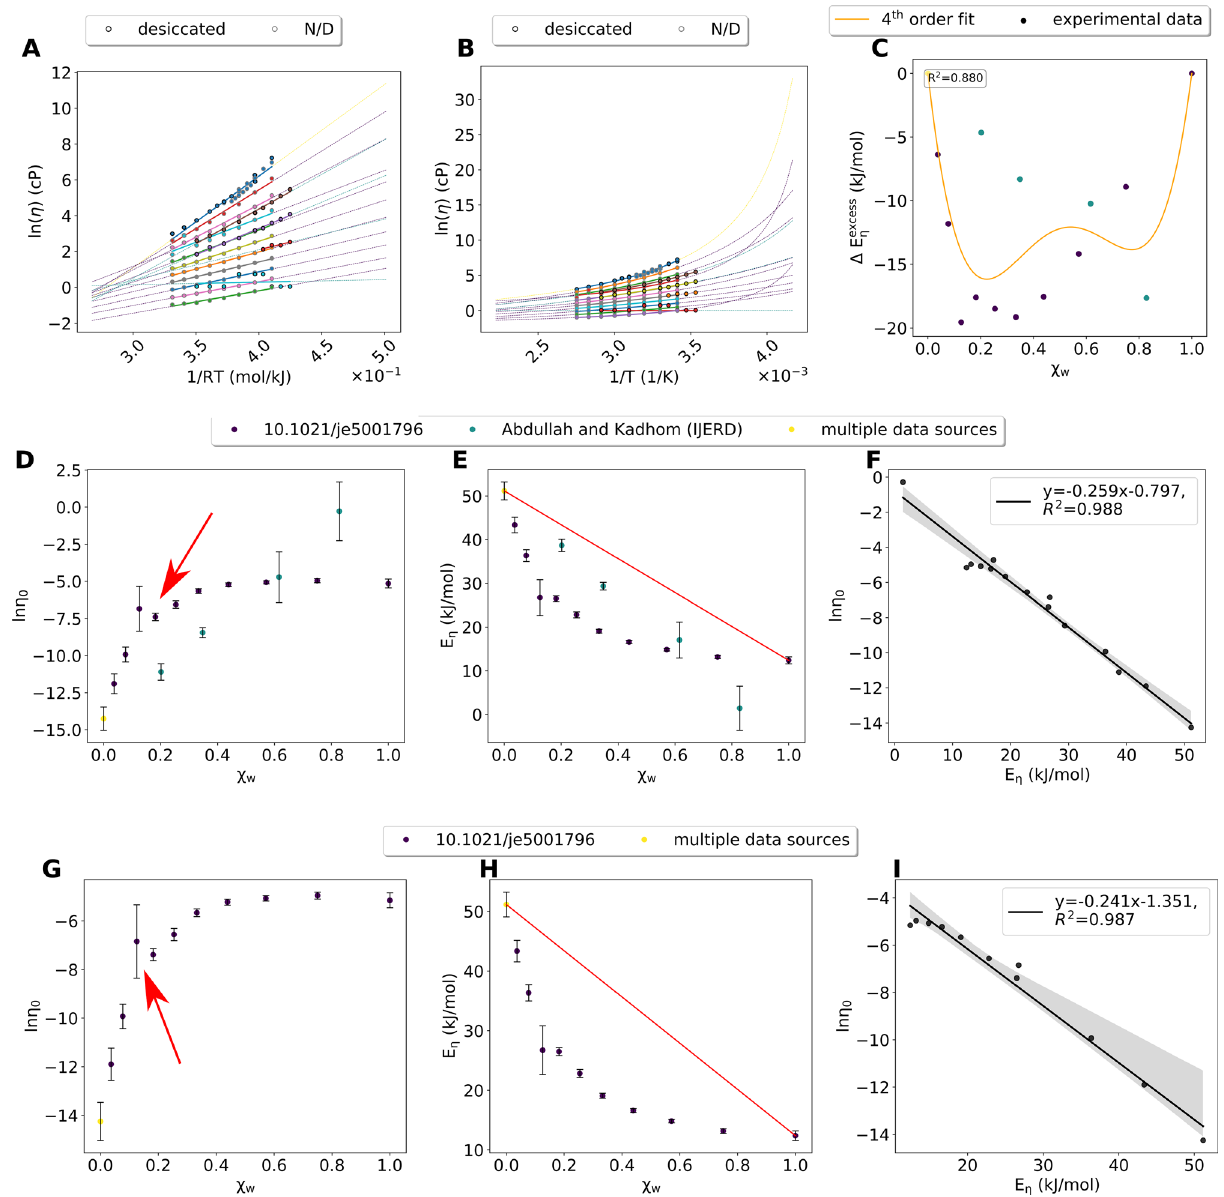
of the fit. Colors of the dashed lines indicate the source of the data. Yellow means multiple data points from different sources were be combined. ( B ) VFT fits (using a minimum of 4 data points). ( C ) E η , calculated based on the red line in ( E ). Colors of the data points indicate the source of the data. ( D ) ln η 0 at different χ w. Error bars are calculated based on the fit in ( A ).The red arrow highlights the data point affected by a presumed typo. Colors of the dashed lines indicate the source of the data. Yellow means multiple data points from different sources were be combined. ( E ) E η at different χ w . The red line indicates the behavior of an ideal binary mixture excess and was used to calculate E η ( C ). ( F ) Correlation between ln η 0 and Eη. ( G – I ): same as ( D – F ), but without data from the source in a predatory journal, but with the data point affected by a presumed typo (red arrow in G